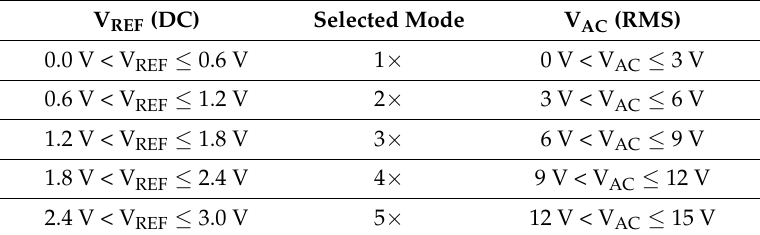
Table 1. LC driver mode selection: the reference voltage vs. output voltage.